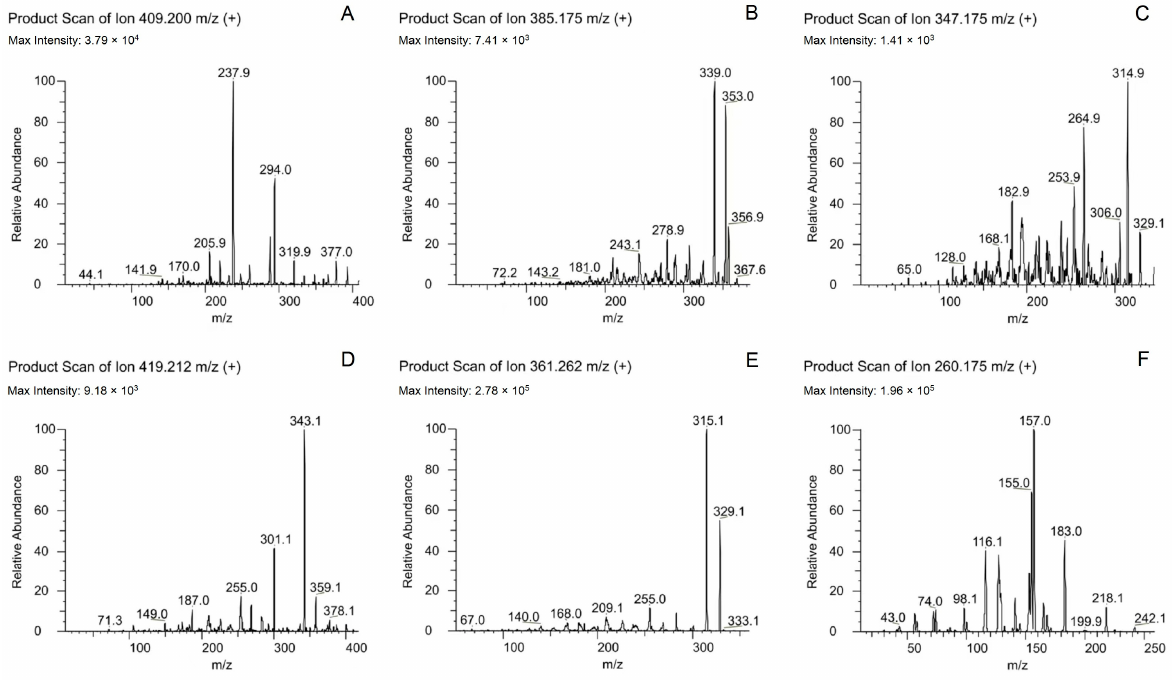
Figure 5. Product ion mass spectra of amlodipine ( A ), felodipine ( B ), nifedipine ( C ), nimodipine